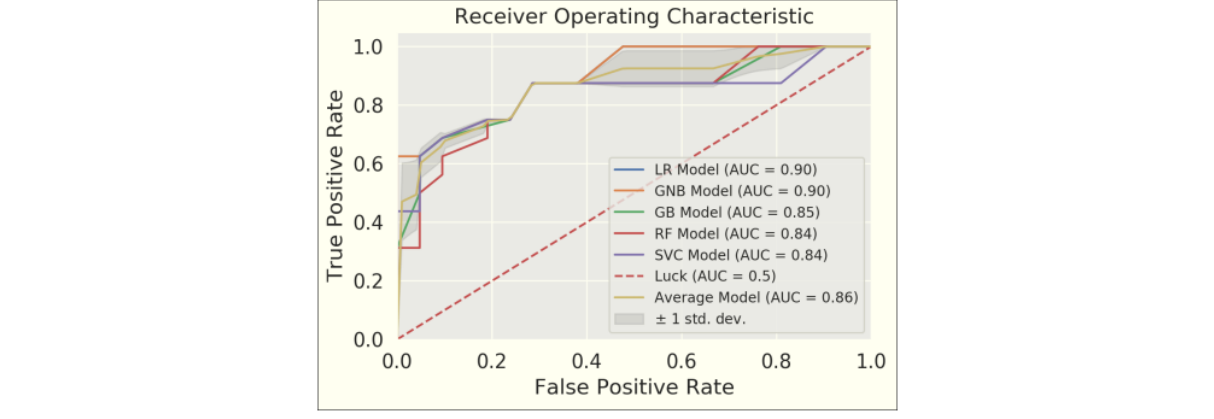
Figure 3. ROC curves and corresponding AUCs for the five models and the average over all five